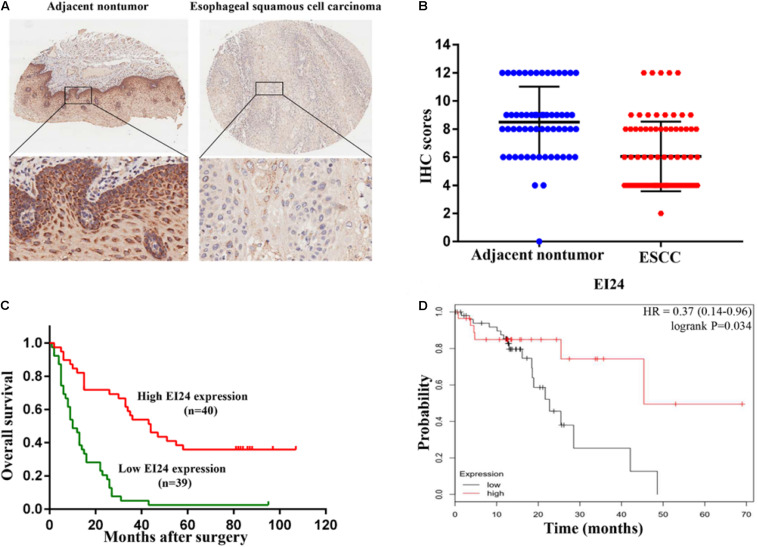
Clinical relevance of EI24 expression in esophageal squamous cell carcinoma (ESCC). (A,B) Representative immunohistochemical (IHC) staining of EI24 expression and IHC scores of ESCC tissues and paratumor tissues. (C) The Kaplan–Meier curves for overall survival according to the EI24 expression (log-rank test; P < 0.001). (D) Patients with higher EI24 expression had a better survival than patients with lower EI24 expression.